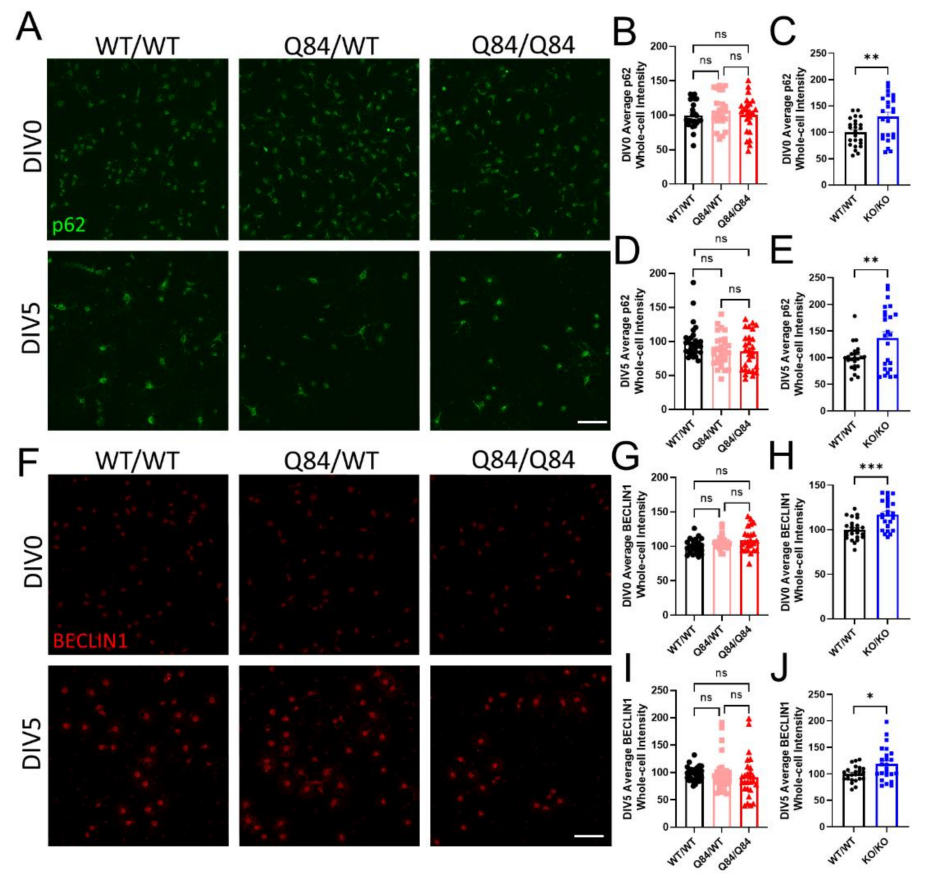
Figure 3. SCA3 oligodendrocytes have no changes in autophagy while the loss of ATXN3 function leads to autophagic dysregulation. ( A ) Representative immunofluorescent images of p62 in